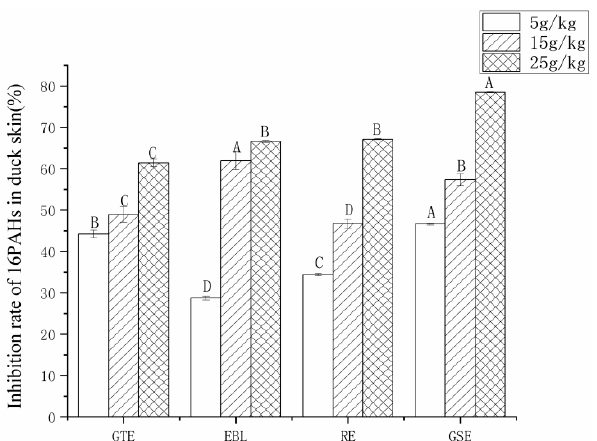
Figure 3. The inhibition rates of 16 PAHs in roast duck skin treated with four different extracts and three levels of addition. Note: GTE: pickling solution with green tea extract; EBL: pickling solution with extract of bamboo leaves; GSE: pickling solution with grape seed extract; RE: pickling solution with rosemary extract. Different letters (A, B, C and D) indicate significant differences comparison among extracts ( p < 0.05).